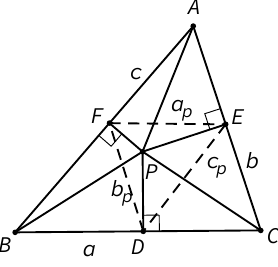
Figure 1. An inequality involving any point P inside triangle ABC is equivalent to the one involving the point P and its pedal triangle DEF with respect to ABC